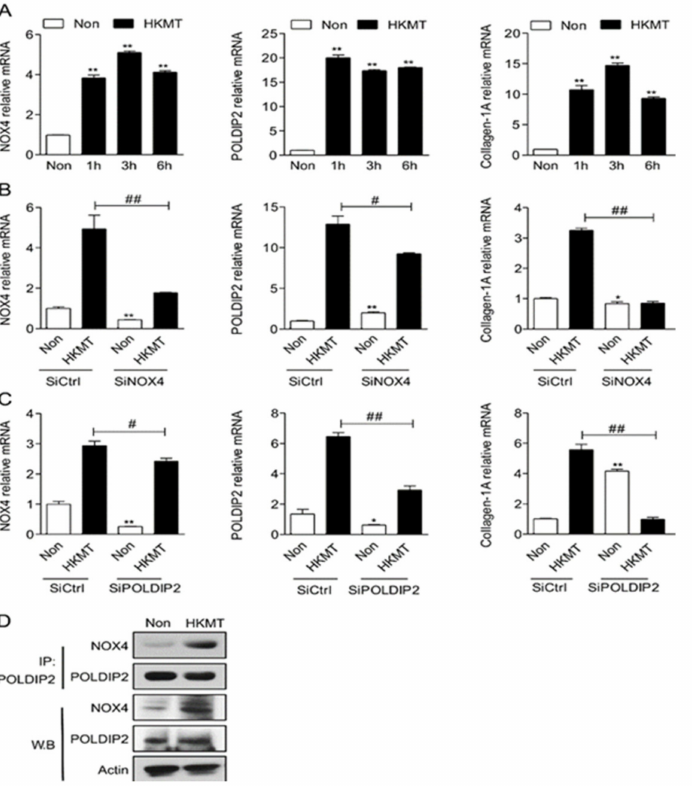
Figure 1. NOX4 and POLDIP2 mutually mediate HKMT-induced collagen-1A synthesis ( A ) NOX4, POLDIP2 and collagen-1A mRNA expression in the Met5A cells over time after HKMT treatment ( B ) NOX4, POLDIP2 and collagen-1A mRNA expression in the Met5A cells with HKMT treatment in the presence of SiCtrl and SiRNA targeting NOX4 (SiNOX4) ( C ) NOX4, POLDIP2 and